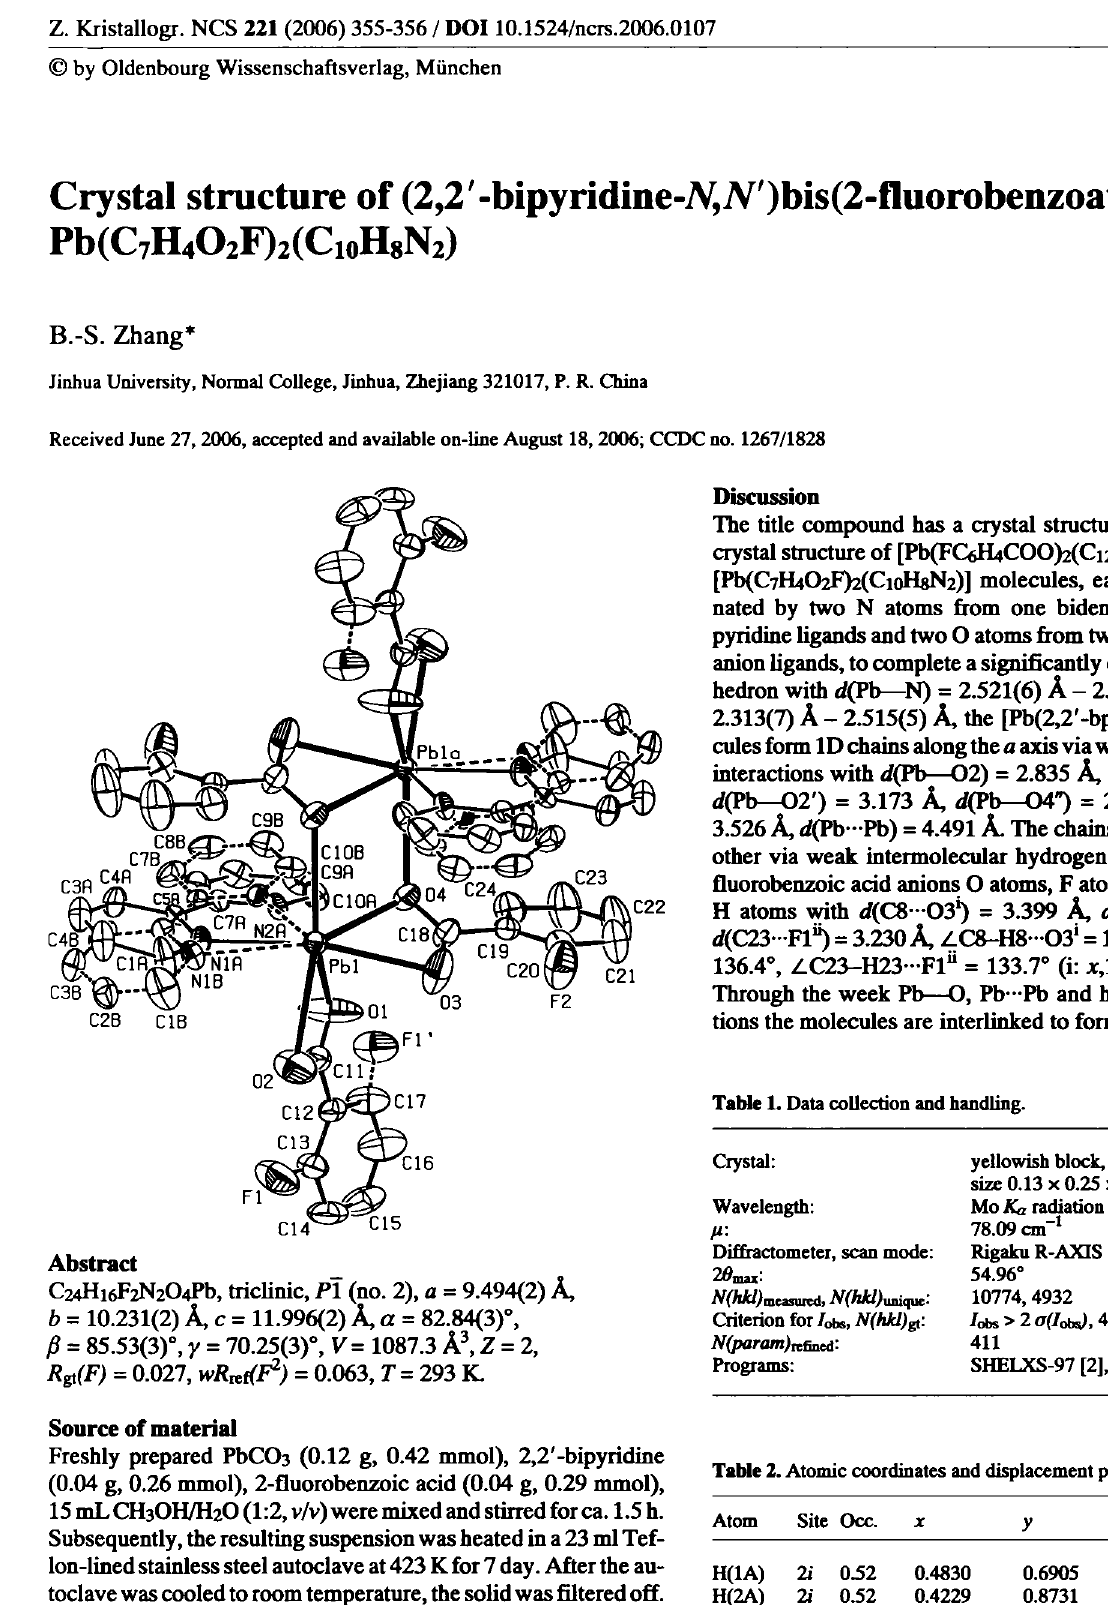
Table 2. Atomic coordinates and displacement parameters (in A 2